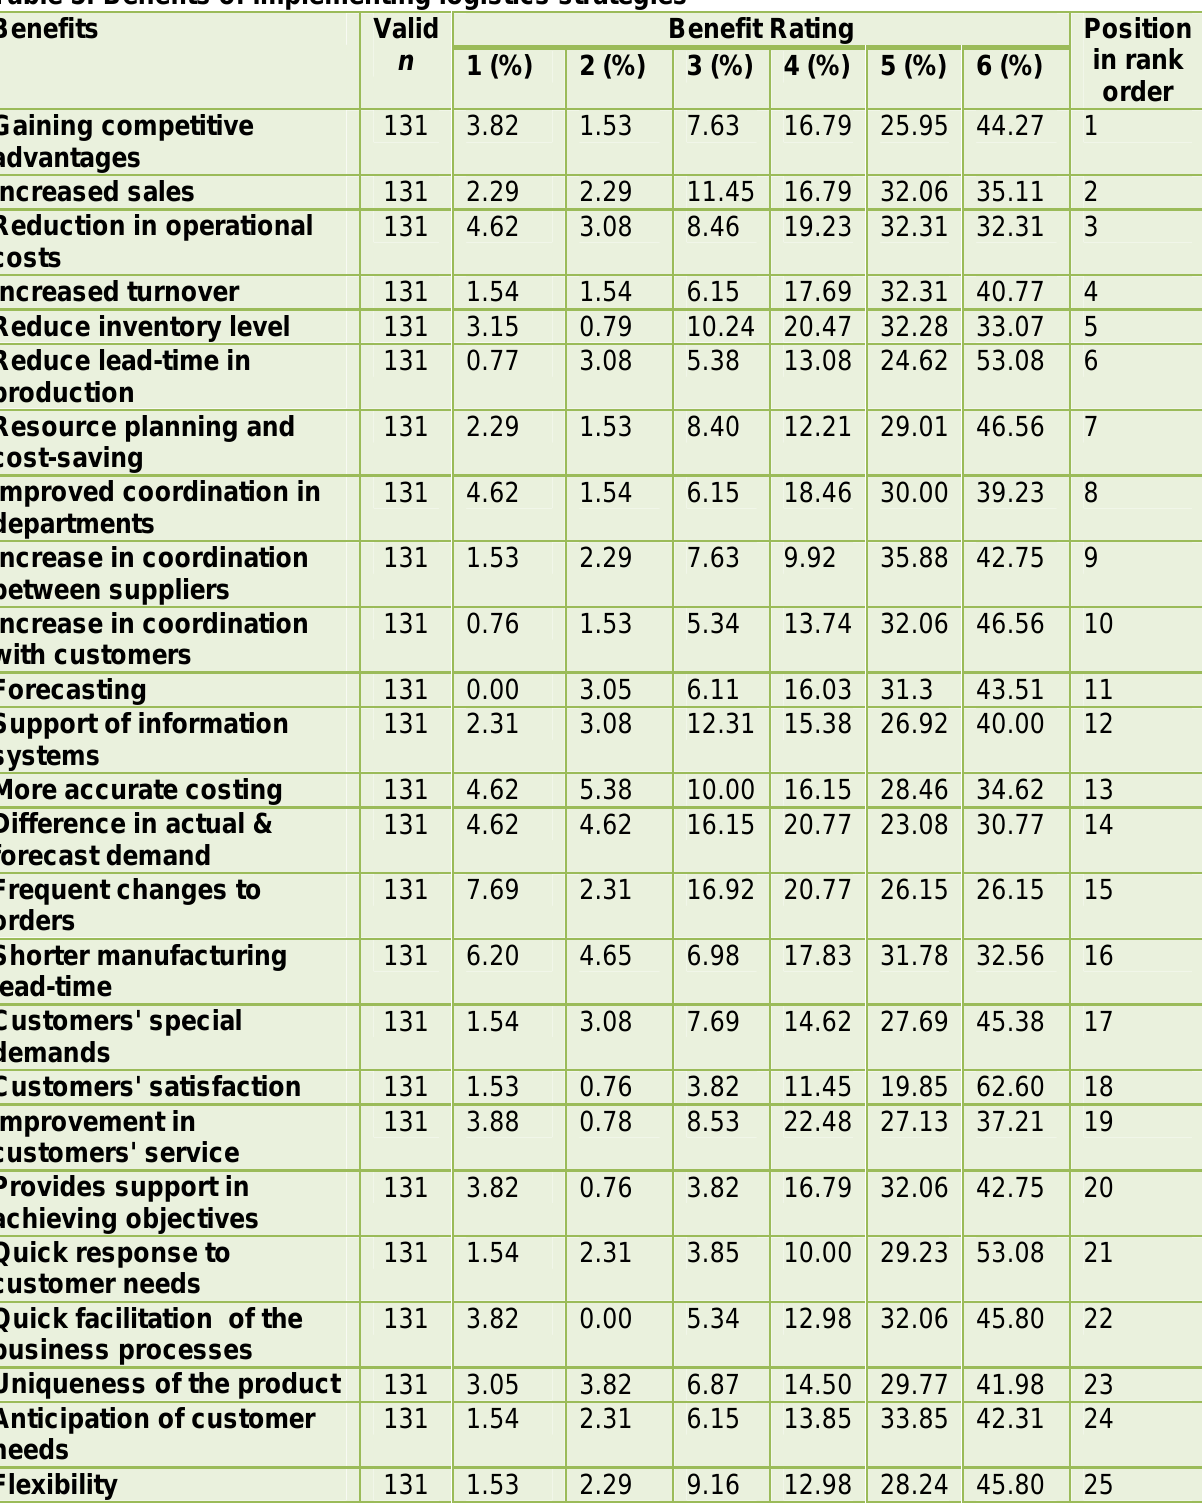
Table 5: Benefits of implementing logistics